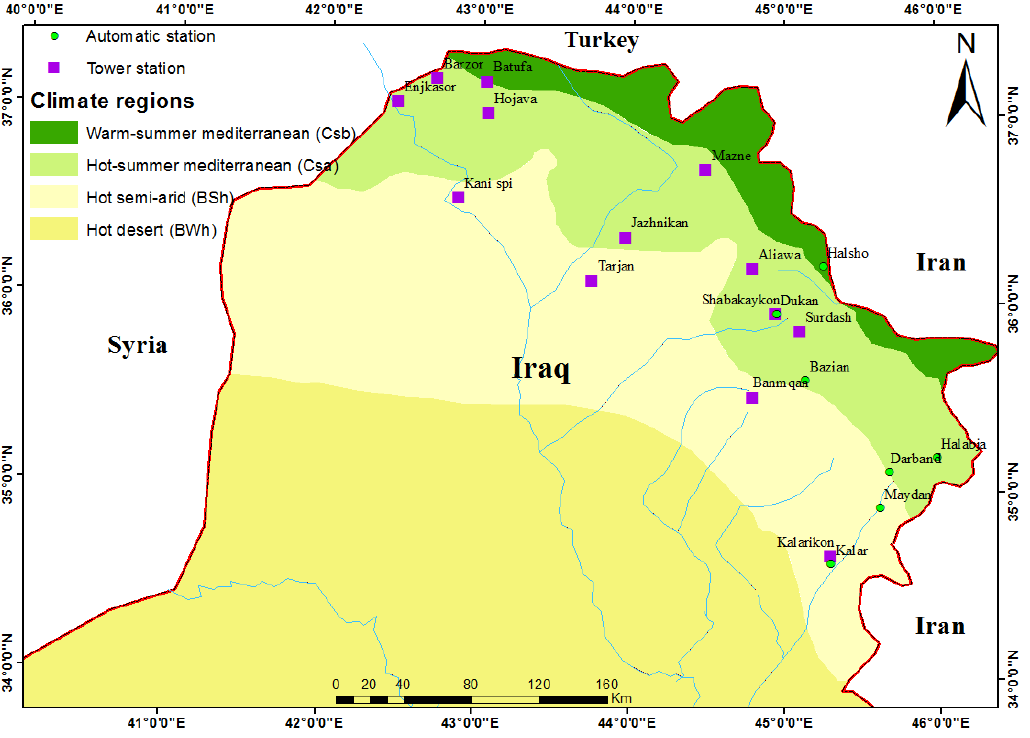
Figure 1. Climate regions, station types and their locations in the study area [36,37].